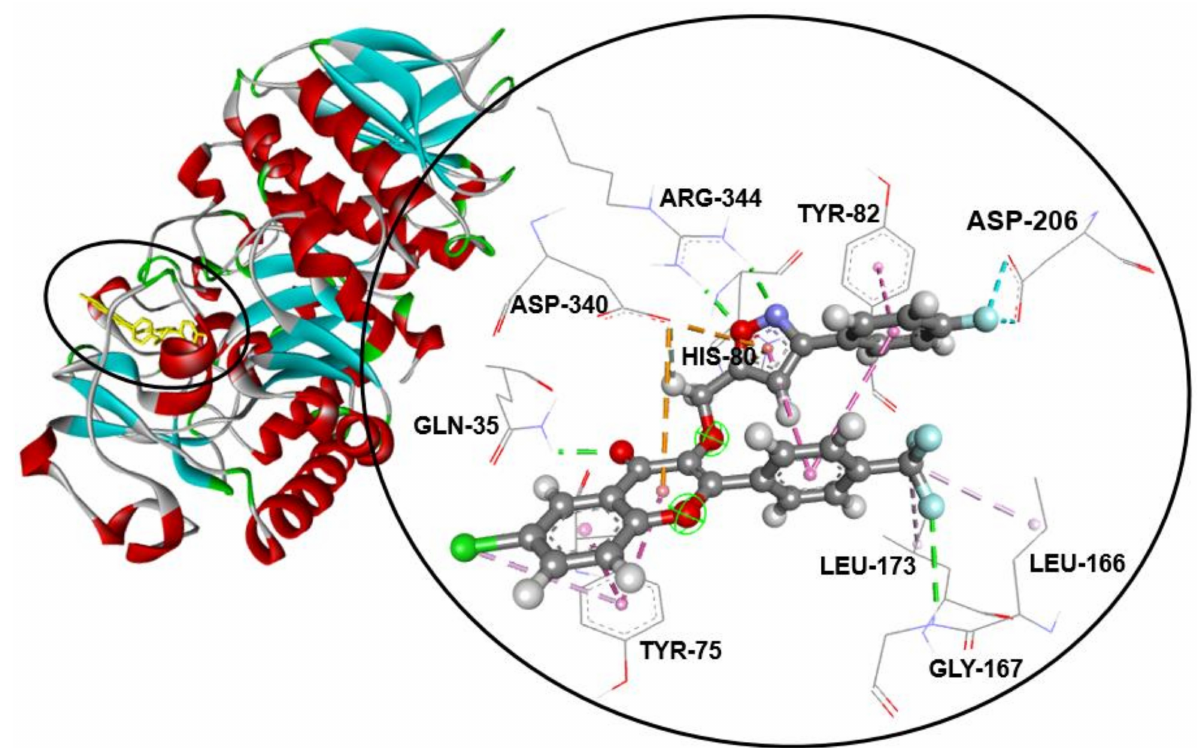
Figure 1. Compound 3b fits into the hydrophobic binding pocket of ABC in PDB: